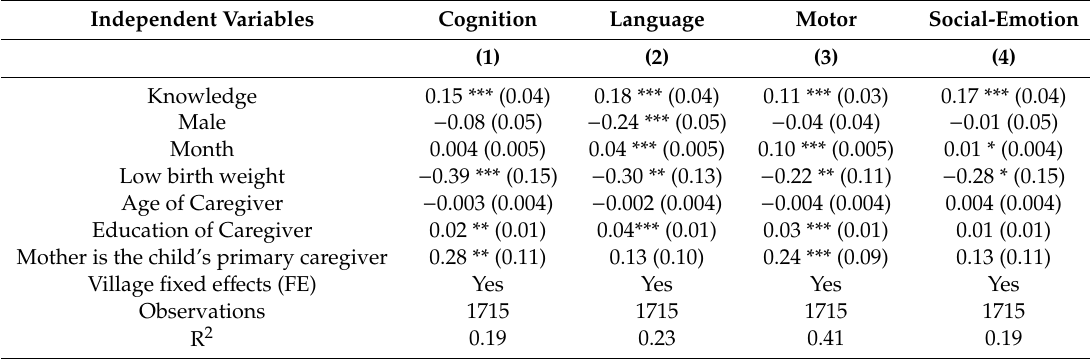
Table 1. Correlation between parenting knowledge and development outcomes.